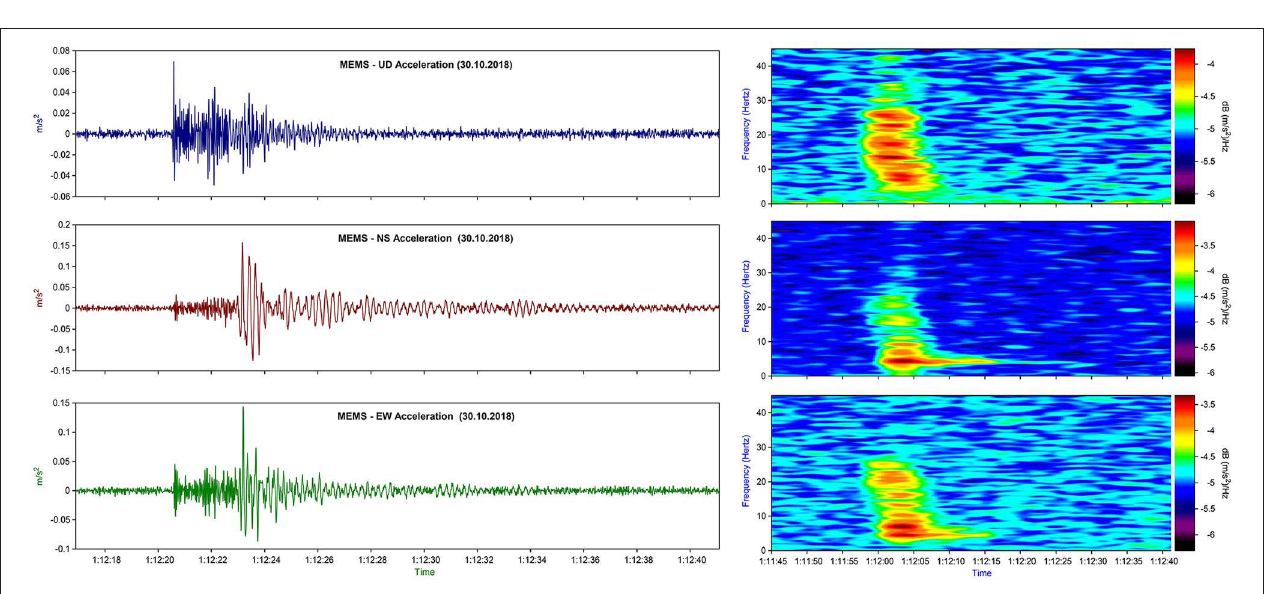
FIGURE 4 | Seismic signals (Left) , band-pass filtered acceleration between 1 and 35Hz, recorded at the MEMS station located in S. Ninfa after the M L 3.1 earthquake occurred on October 30th, 2018 and located 5km away from the monitoring station (30s time window), and relative spectrograms (Right)